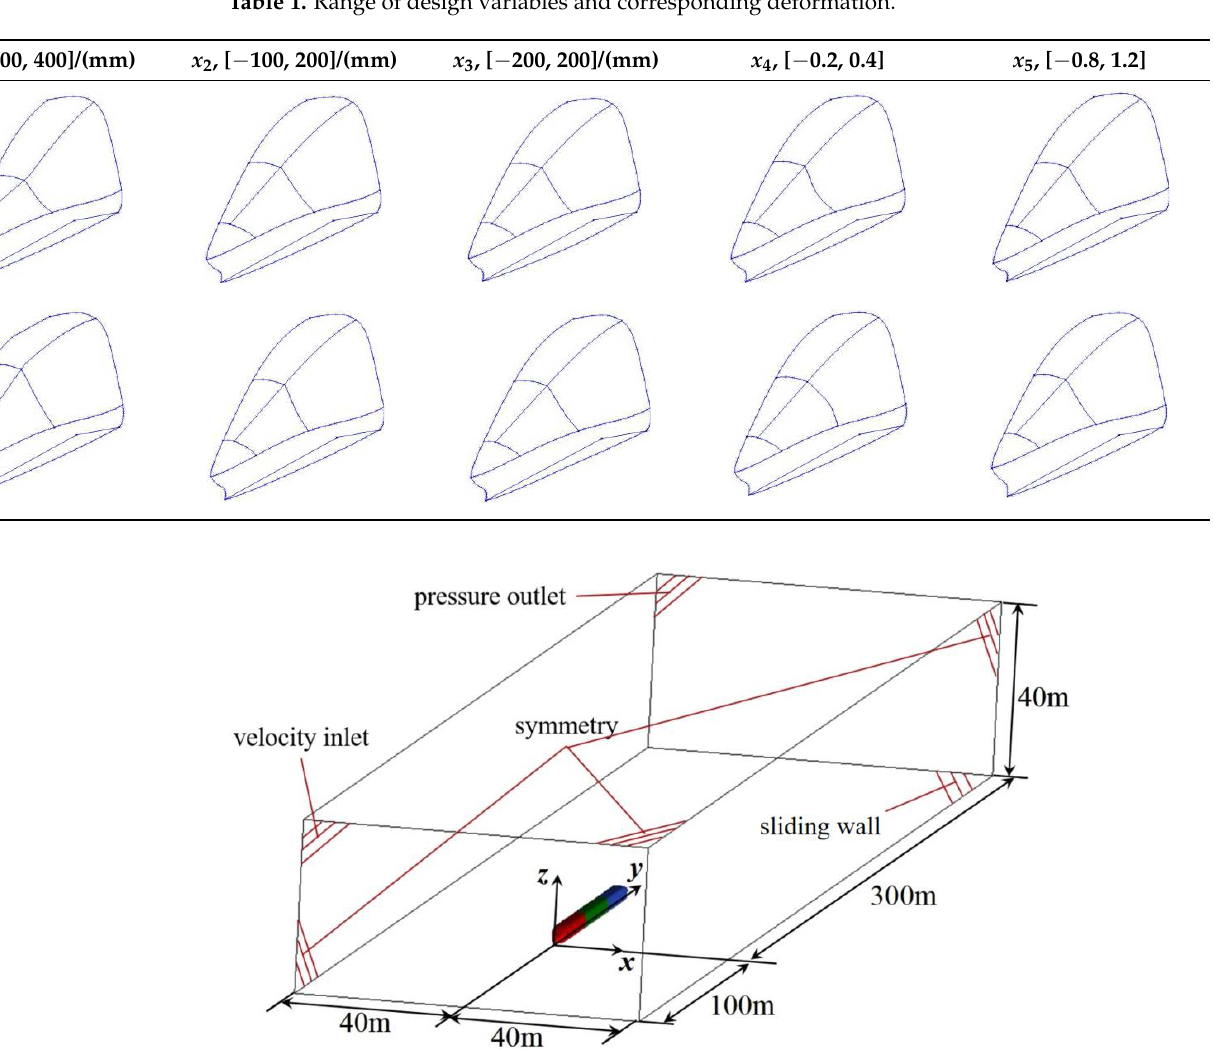
Figure 3. Computational domain and boundary condition.